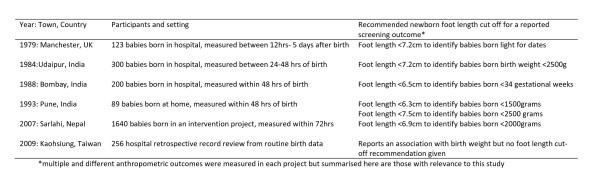
Recommended newborn foot lengths for identification of small babies reported in peer-reviewed literature [11-16].